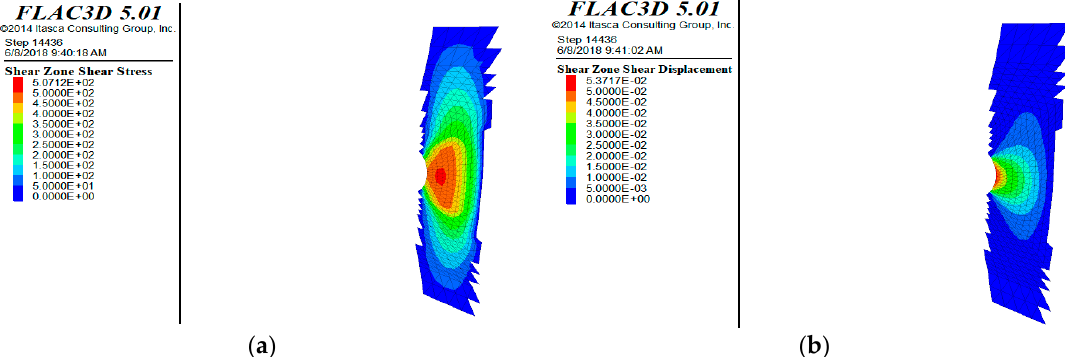
Figure 14. Contour shear zone: ( a ) shear stress and ( b ) shear displacement.